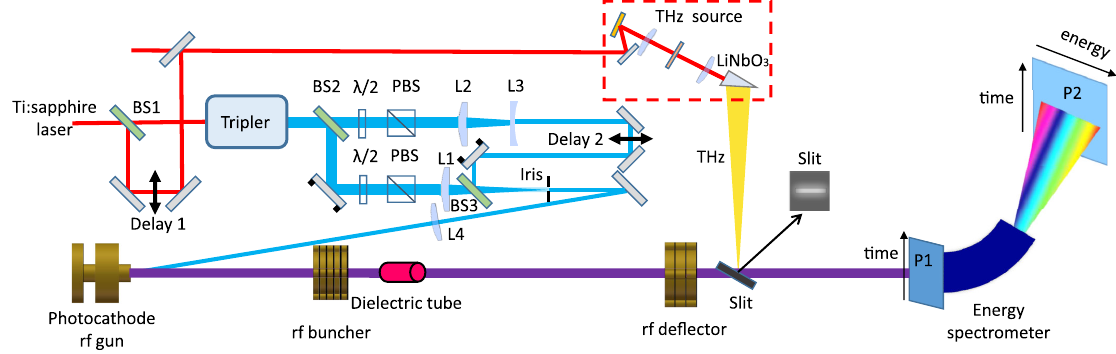
FIG. 1. Wakefield-driven relativistic electron beam compression experiment setup. The 800 nm laser is split into three pulses with two pulses used for producing electron beams and the third pulse for producing THz radiation. The trailing witness beam is compressed by the wakefield generated by the leading drive beam in a dielectric tube. The temporal profile of the witness beam is measured with an rf deflector and its arrival time is measured with THz streaking in a